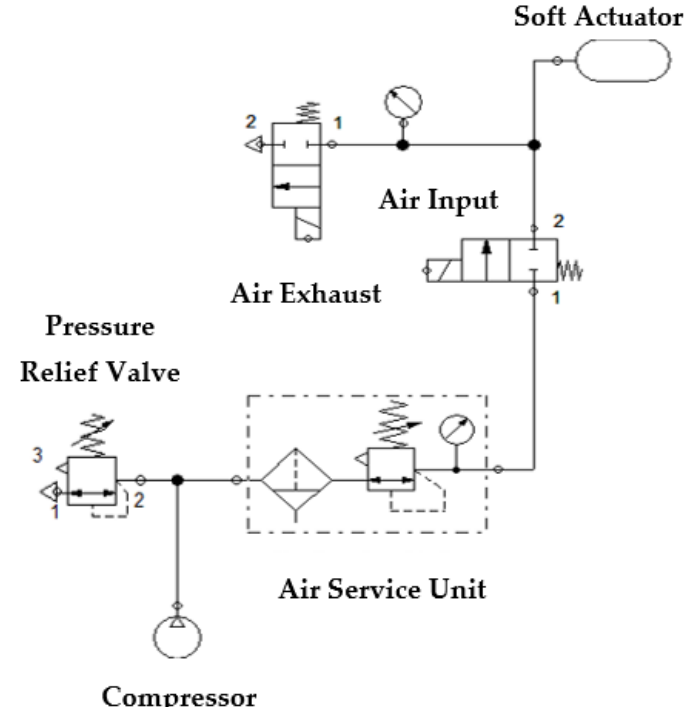
Figure 9. Pneumatic Circuit design for